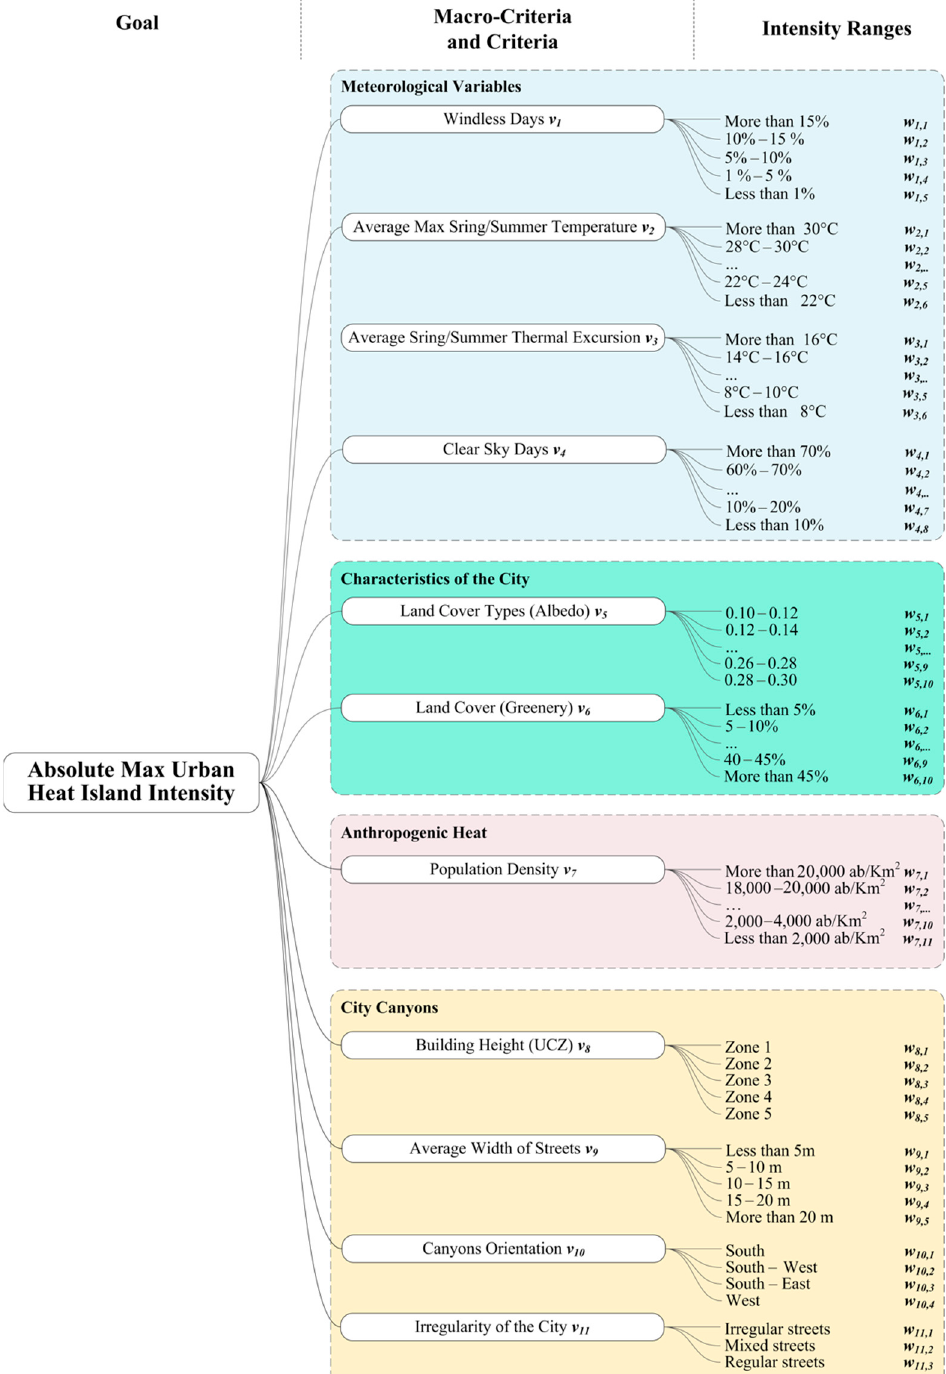
Figure 1. Weight criteria and intensity ranges to define the index 𝐼 (cid:3022)(cid:3009)(cid:3010)(cid:3010) in urban district [18].